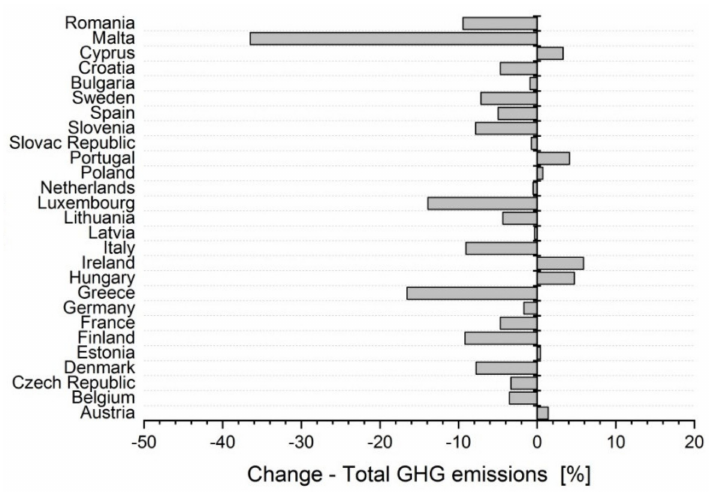
Figure 2. Percentage of aviation’s contribution to the total greenhouse gas emissions in the European Union [45].